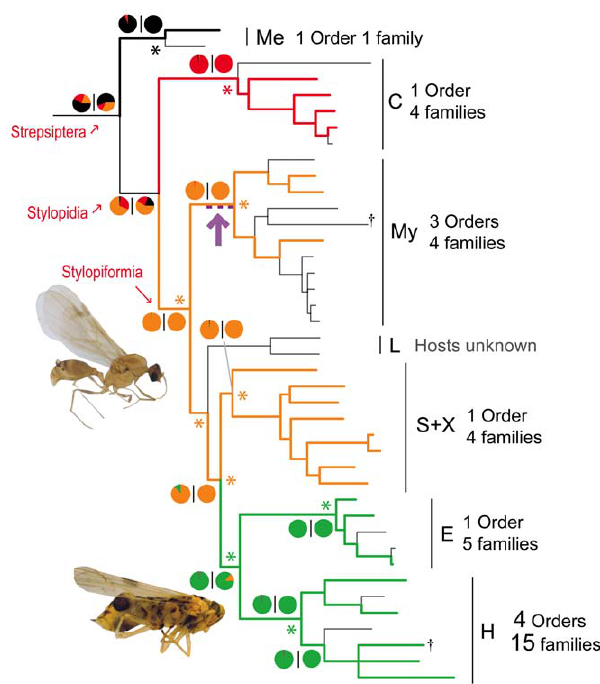
Figure 3. Bayesian reconstruction of male host-usage accord- ing to infra-ordinal grouping. Known host records are given next to clades. Unshaded lines=unknown records/equivocal reconstructions. Black = Lepismatidae; Red = Heteroptera; Orange = Hymenoptera; Green=Auchenorrhyncha; Purple=possible origin of heteronomy. *Significant node reconstructions using BFs. Pie charts=posterior probability | ML support. BFs and support charts not shown below family. { Probable parthenogens. Clade abbreviations follow Figure 1B. Images: Pheidole sp. (Hymenoptera) with male cephalotheca (top). Sogatella furcifera (Homoptera) with Elenchus japonicas male puparium. Photographs (cid:2) J. Kathirithamby.